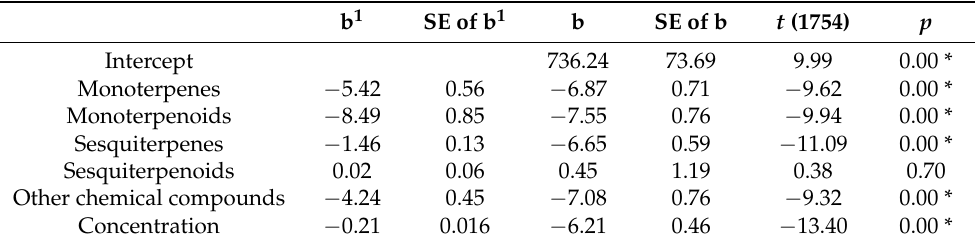
Table 4. The model of multiple regression: b—regression coefficient; b 1 —standardized coefficient; SE standard error; t —Student’s t -test value. b